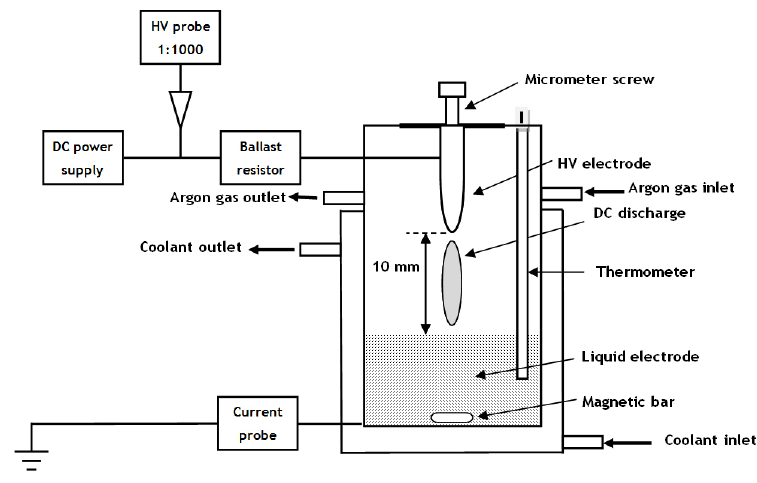
Figure 1: The scheme of the reactor of glow discharge above water used for AB25 degradation with Ar gas